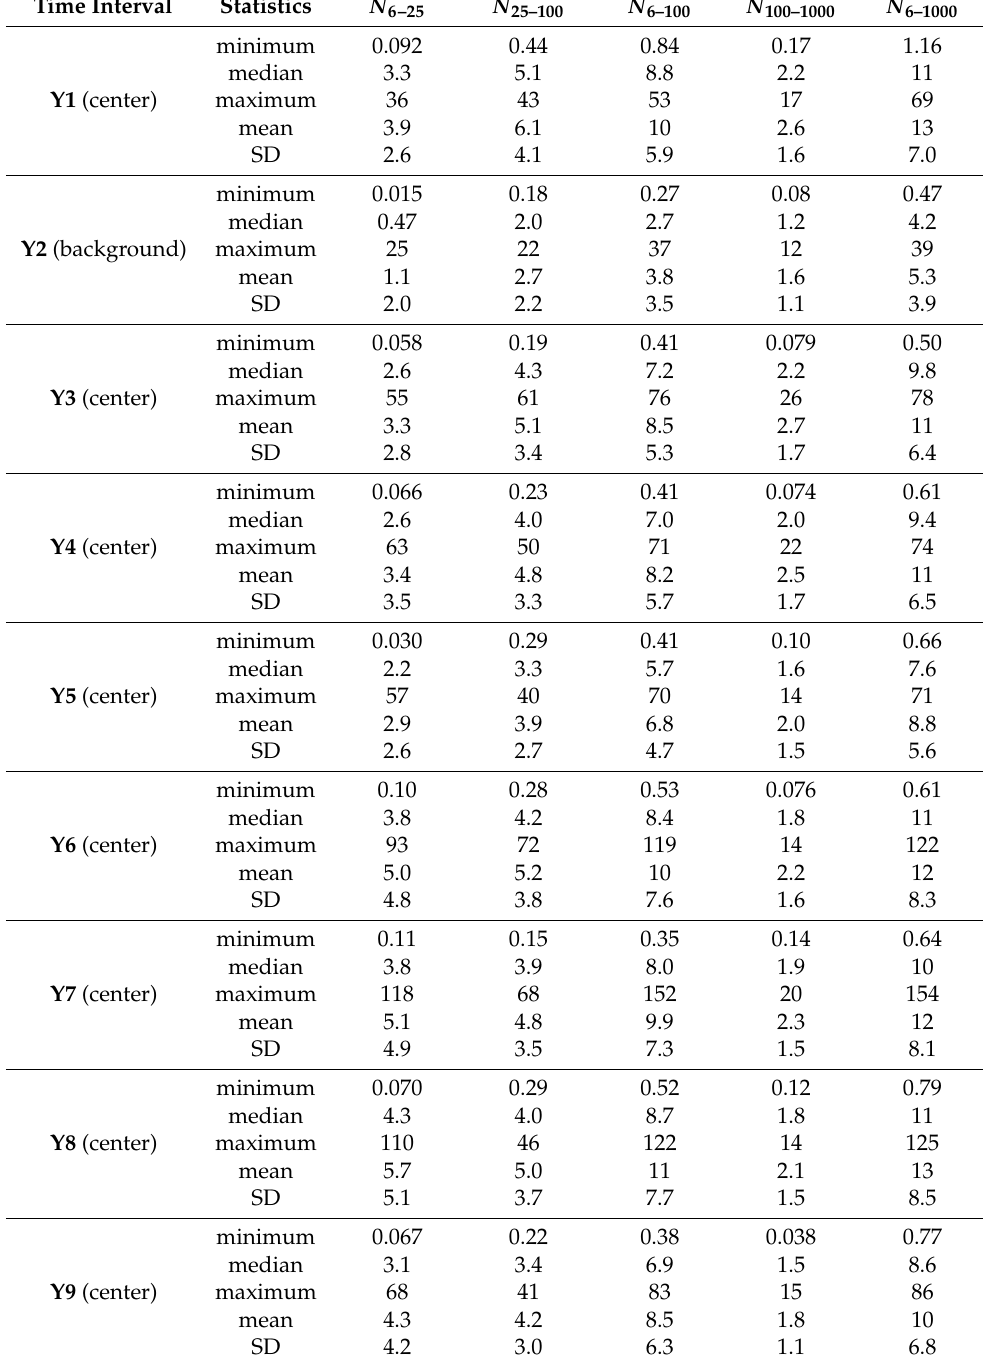
Table 1. Ranges, medians, and means with standard deviations (SDs) of particle number concentra- tions N 6–25 , N 25–100 , N 6–100 , N 100–1000 , and N 6–1000 (all in 10 3 cm − 3 ) in the city center and near-city background for the measurement years Y1 to